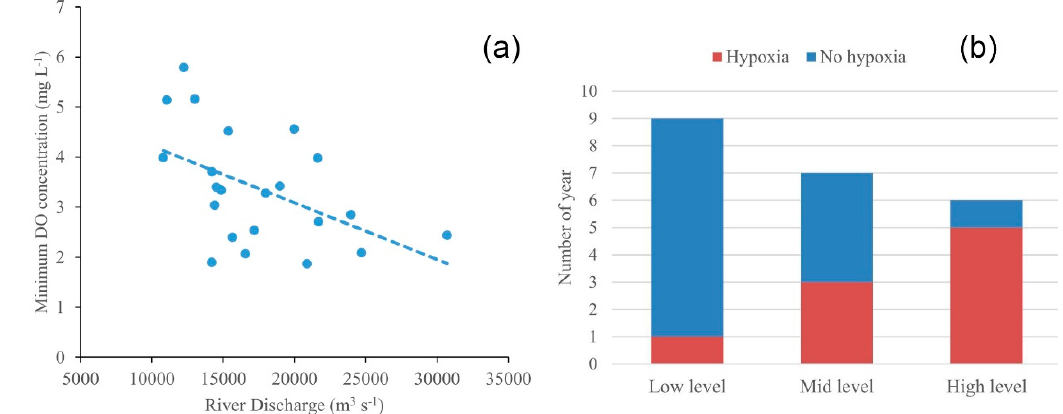
Figure 18. ( a ) Minimum DO concentration vs. river discharge during June–September in the PRE based on multi-year (1982~2006) DO observation data (note that there were no data in 1985, 1998, and 2004). ( b ) The number of year with / without hypoxia occurrence at a low-level ( < 15,000 m 3 s − 1 ), mid-level (15,000~20,000 m 3 s − 1 ), and high-level ( > 20,000 m 3 s − 1 ) of Pearl River discharge in summer.